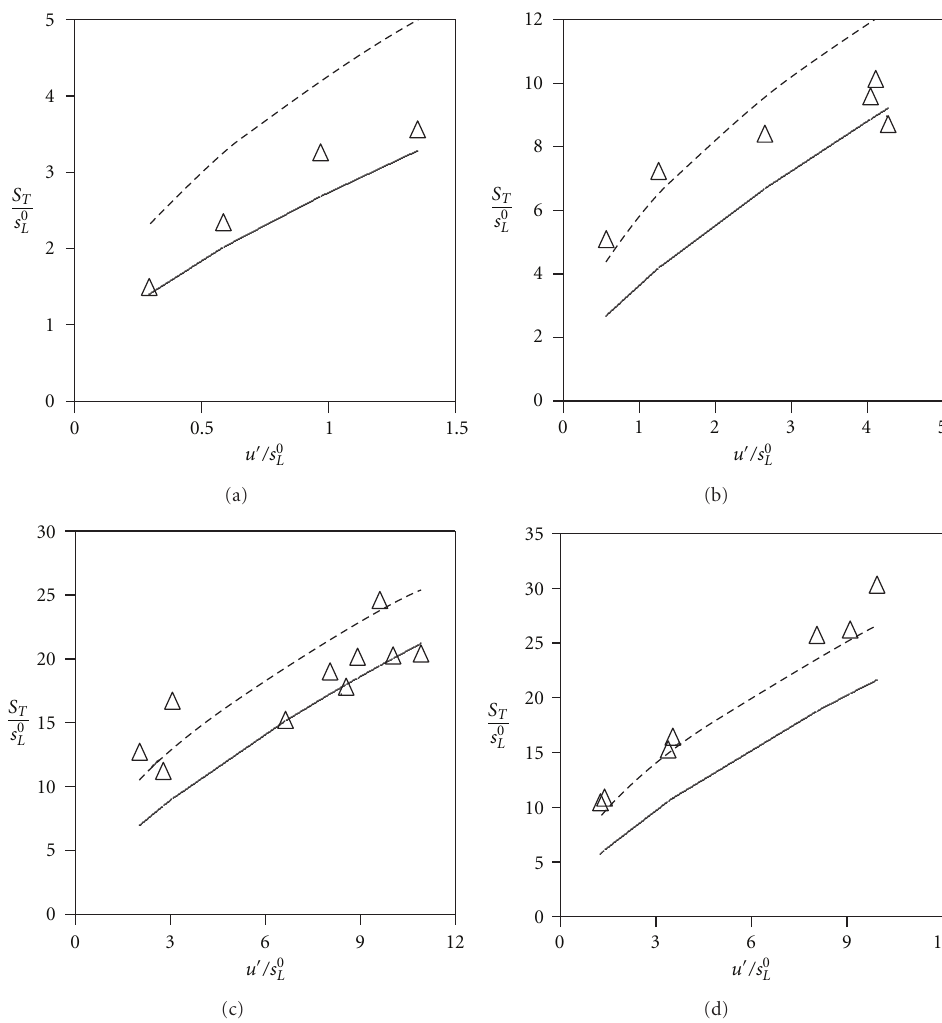
Figure 3: The predictions of the flame speed expressions, (6) (solid line) and (8) (dashed line), are compared to the high pressure Bunsen flame data of [33]: (a) 0.1 MPa; (b) 0.5 MPa; (c) 2MPa; (d)